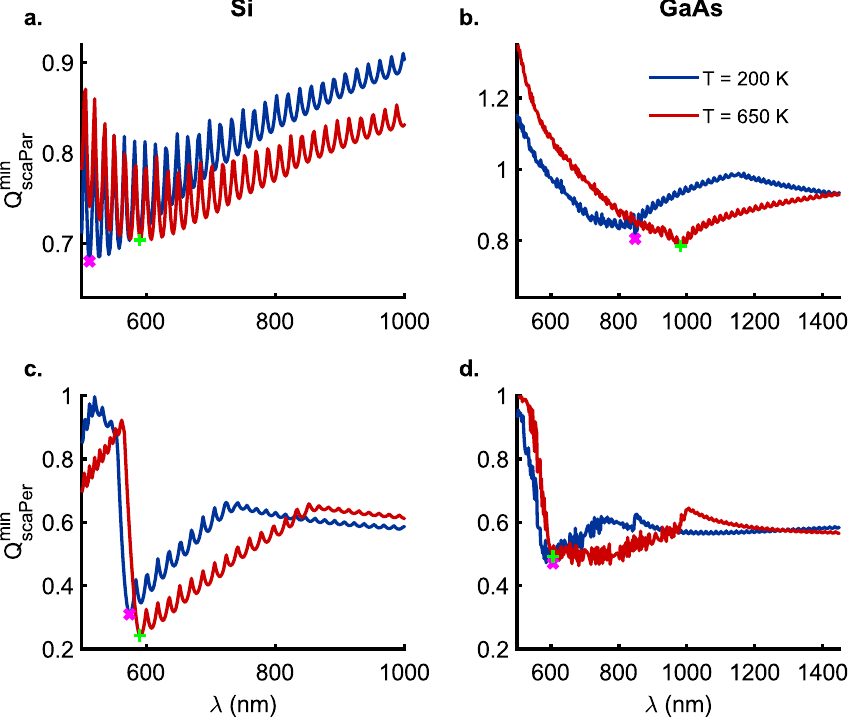
min Figure 5. Spectral trajectory of Q ) ( a ) Si, ( b ) GaAs, and, TE ( E ) polarizations ( c ) Si and ( d ) sca for the TM ( E (cid:31) ⊥ GaAs along the minima (dashed white line) plotted in Figs. S1 and S2 for Q scaPar and Q scaPer as a function of the 200 K and T 650 K nanowire radius and the wavelength of the incident radiation for the temperatures T = = respectively. The magenta ( ) and green ( ) markers denote the global minima in scattering efficiencies for × + nanowire radii ( r > 50 and 125 nm for TM and TE polarizations, respectively) that exhibit distinct scattering resonances as opposed to the monotonic spectral behavior observed for the smaller nanowire radii. Here, note that the points on the continuous curves shown for the two temperatures, in general, represent scattering minima at given wavelengths for nanowires with distinct radii as can be seen in the Figs. 6 and 7 wherein the radii of the nanowires corresponding to the markers ( ) and ( ) are clearly × +